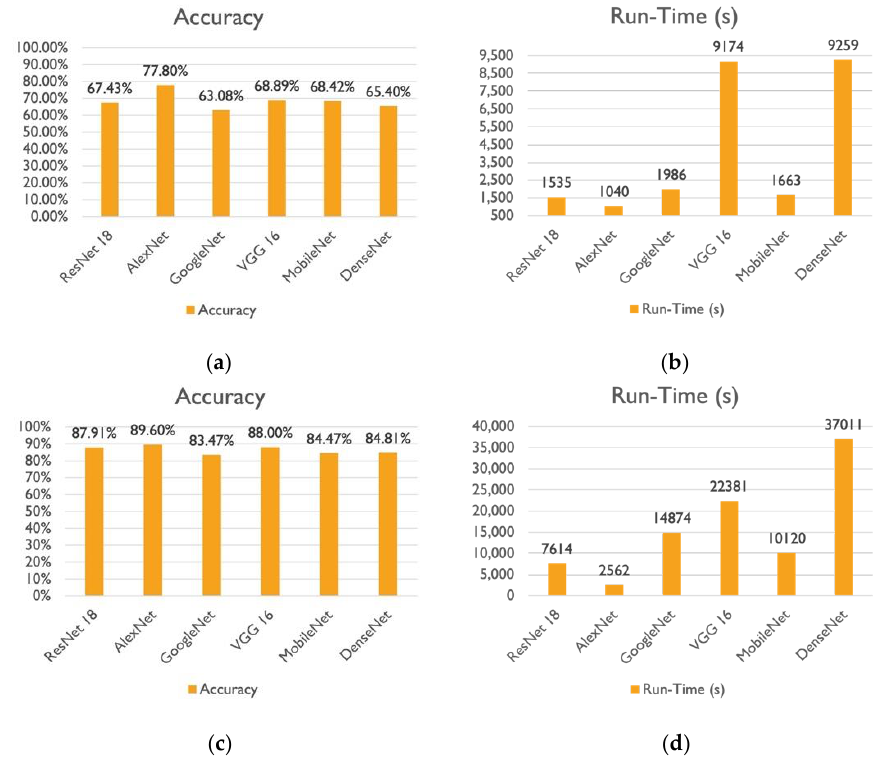
Figure 7. Comparison between DL models using ( a ) Dataset 2 in terms of accuracy, ( b ) Dataset 2 in terms of run-time, ( c ) Dataset 3 in terms of accuracy, ( d ) Dataset 3 in terms of run-time.